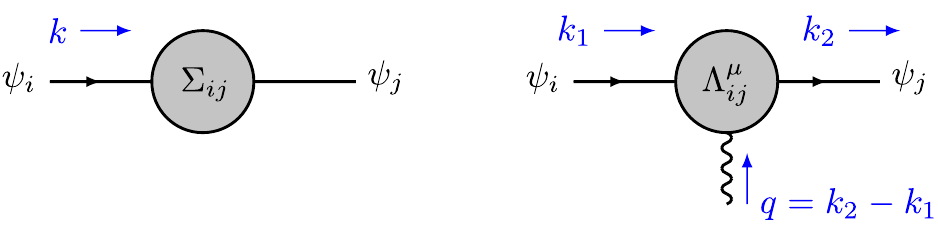
Figure 4 . Assignment of the momenta for the self-energy and vertex